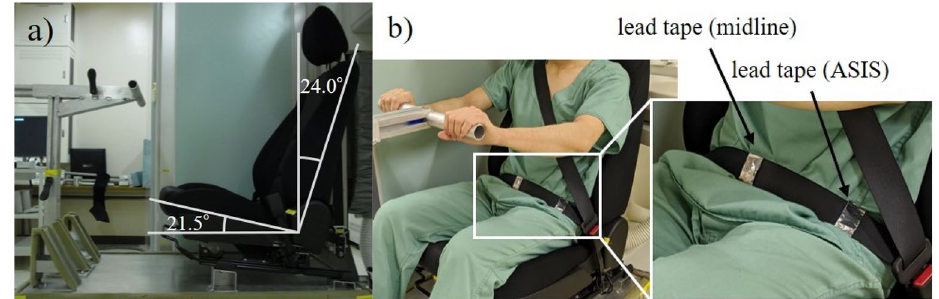
Figure 2. X-ray table using Mazda 3 car seat. ( a ) The back of the seat was fixed at 24 degrees, and the seat surface at 21.5 degrees. The handle that imitates the steering wheel, and the pedals, were placed in the same positions as in the actual vehicle. ( b ) The midline and left ASIS equivalent positions of the lap belt were marked by wrapping 3 M™ lead foil tape 420 (25.4 mm × 32.9 mm) around each position so that they could be identified radiographically. In each case, the first author palpated and confirmed the center of the abdomen and the left ASIS, and positioned the